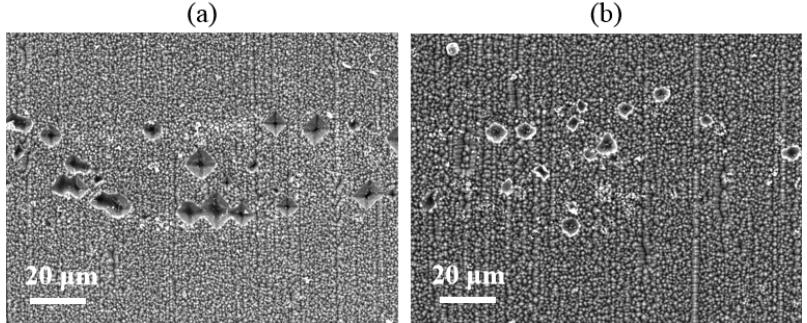
Figure 12. Si substrate surface etched area scanning electron microscope (SEM) images of the cells with ( a ) and without ( b ) adding Si particles.